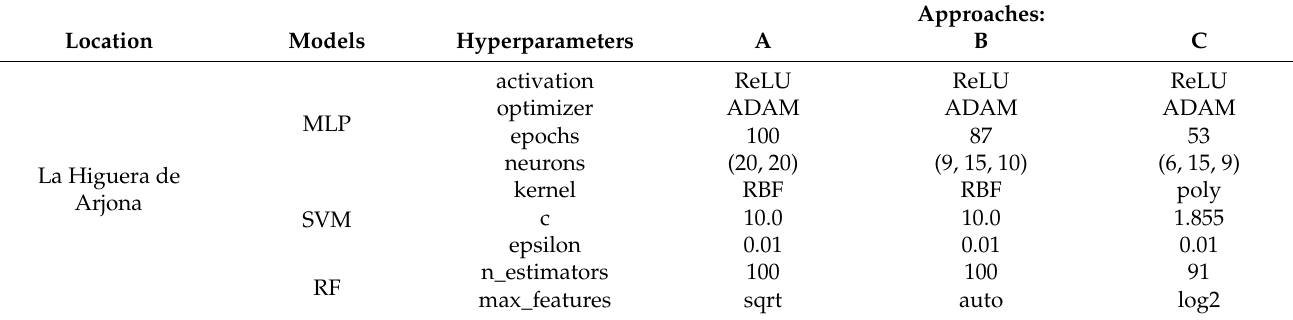
Table 3. Hyperparameter set for each model, approach, and location, after carrying out Bayesian optimization, where activation represents the activation function, the optimizer represents the optimizer function, epochs represents the number of epochs, neurons represents the number of hidden layers and the number of neurons of each, kernel is the kernel function, c and epsilon represent internal hyperparameters of SVR, n_estimators is the number of trees in RF, and max_features is the number of features to consider when looking for the best